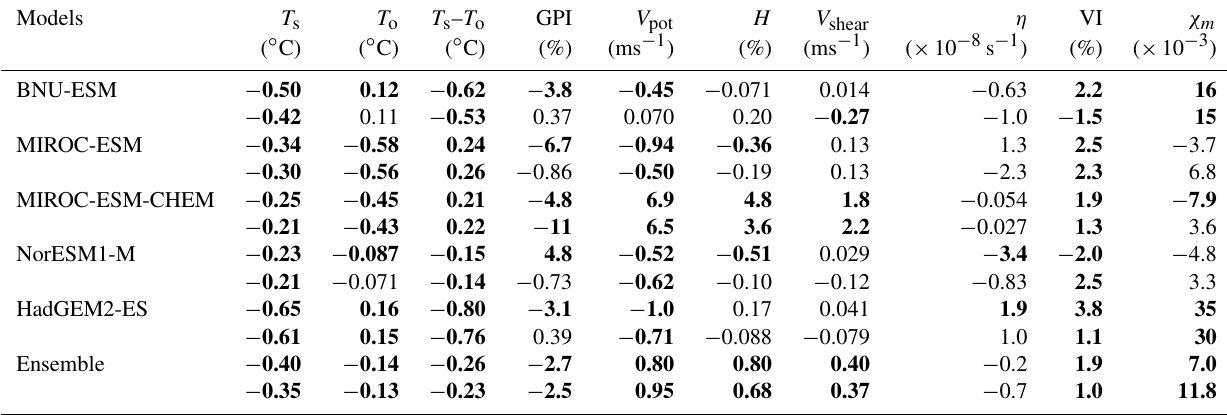
Table 3. Differences (G4 − RCP4.5) in TC basins and season during 2020–2069 year calculated point by point. Northern Hemisphere numbers are above and Southern Hemisphere below. GPI and VI are expressed as percentages ((G4 − RCP4.5) / RCP4.5). Bold fonts are significant at 95% level according to the Wilcoxon signed-rank test.